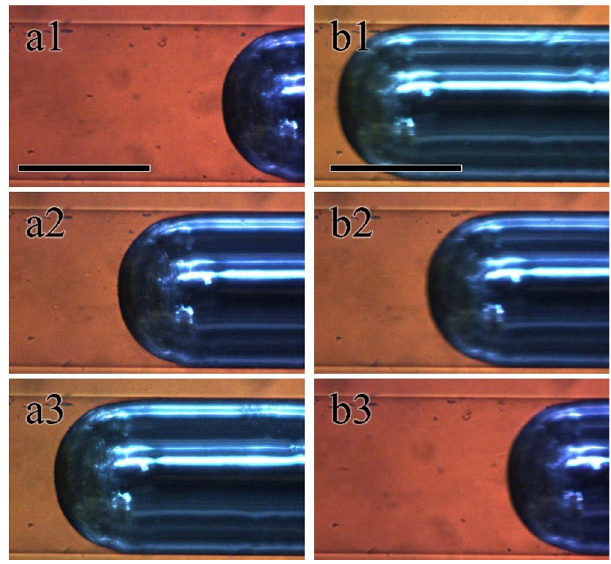
Figure 2. Optical microscopic images of Galinstan droplet in microchannel. ( a1 – a3 ) Galinstan droplet in silicone oil under positive pressure. The snapshots were taken every 5 s. ( b1 – b3 ) Optical microscopy images of Galinstan in silicone oil under negative pressure. Snapshots were taken every 1 s. The scale bars indicate 500 μm.